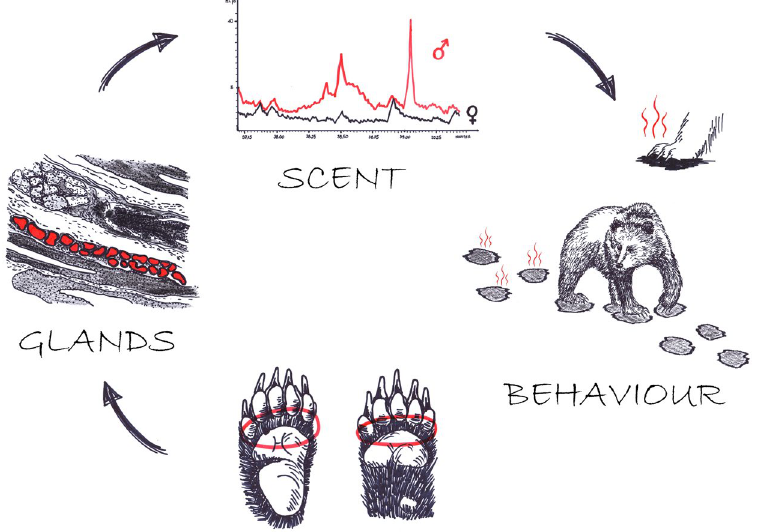
Figure 4. Graphical abstract. The study demonstrates that brown bears do have pedal glands that produce specific and sexually dimorphic scent, and display behavioural patterns related to pedal marking. Drawings credits Katarzyna